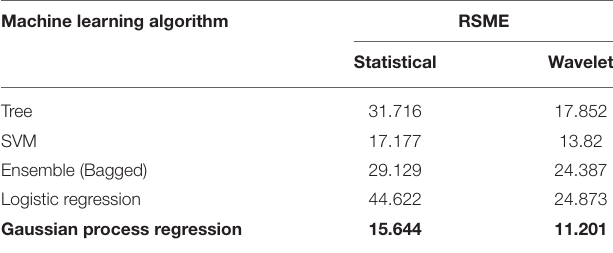
TABLE 4 | Performance metrics for retinal ganglion cells (RGCs)